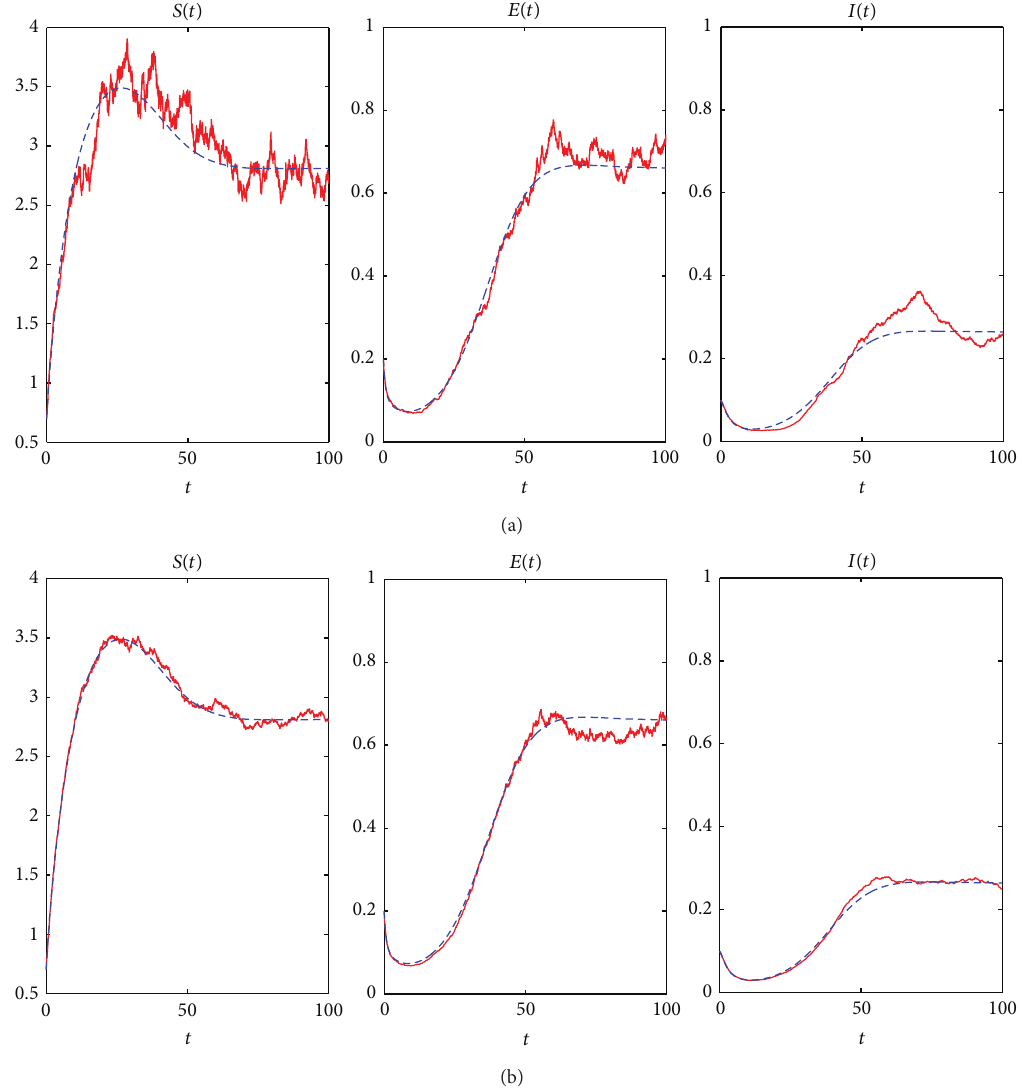
Figure 4: 𝑆(0) = 0.7 , 𝐸(0) = 0.2 , 𝐼(0) = 0.1 , Λ = 0.4 , 𝛽 = 0.8 , 𝜇 = 0.1 , 𝛿 = 0.3 , 𝛾 = 0.6 , 𝜖 = 0.2 , 𝑑 = 0.1 , and Δ𝑡 = 0.002 . Group (a) 𝜎 1 = 0.04 , = 0.03 , and 𝜎 = 0.02 . Group (b) 𝜎 𝜎 2 3